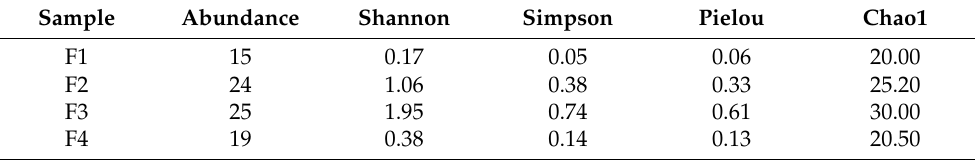
Table 2. Comparison of benthic algae community characteristics at a different flow velocity. Sample Abundance Shannon Simpson